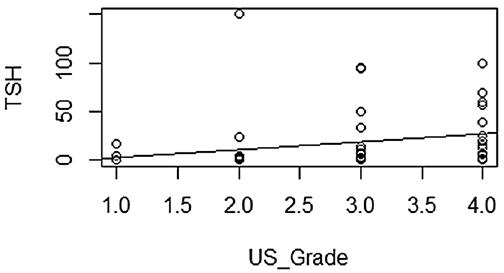
Figure 6. Graphic presentation of linear positive correlation of the TSH level and the severity of US grades in hypothyroidism. (R software, ver. 4.0.4; R Foundation for Statistical Computing, Vienna, Austria).